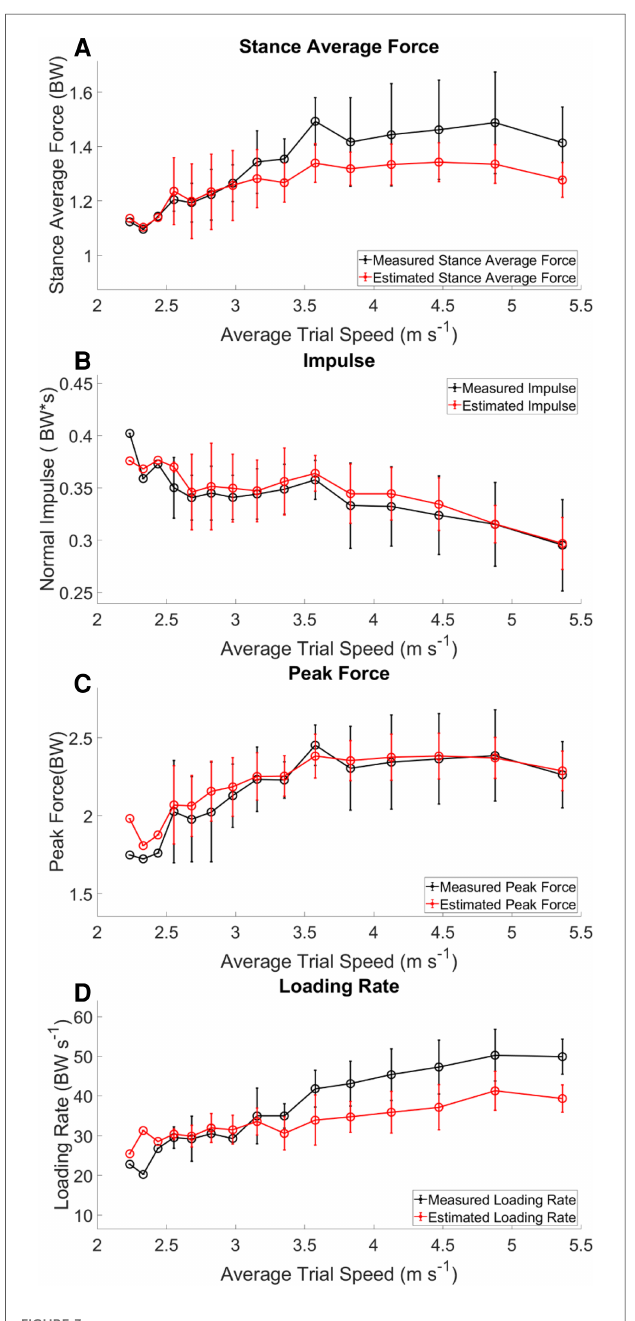
FIGURE 3 Kinetic variables across velocities. Measured (black) variables calculated directly from the force sensing insoles. Estimated (red) calculated from the LSTM estimated waveform. The trends in the estimated data follow those of the measured data, there is however an offset between the two.